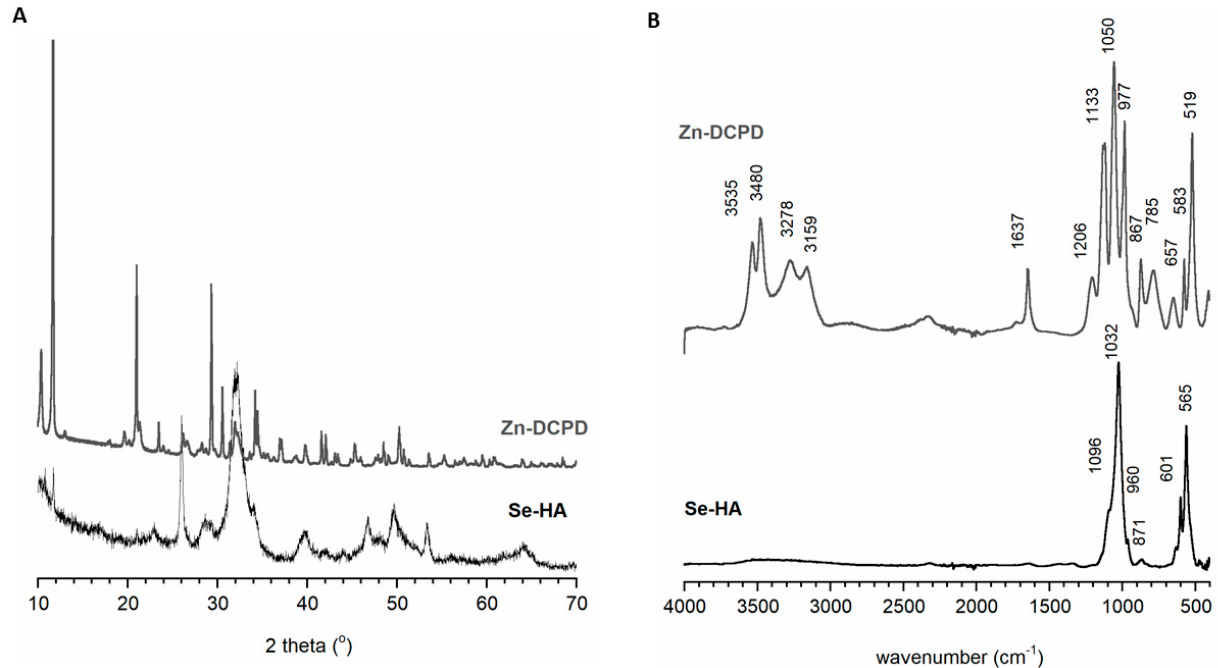
Figure 2. PXRD diffractograms ( A ) and FT ‐ IR spectra ( B ) of the obtained Zn ‐ DCPD and Se ‐ HA samples.